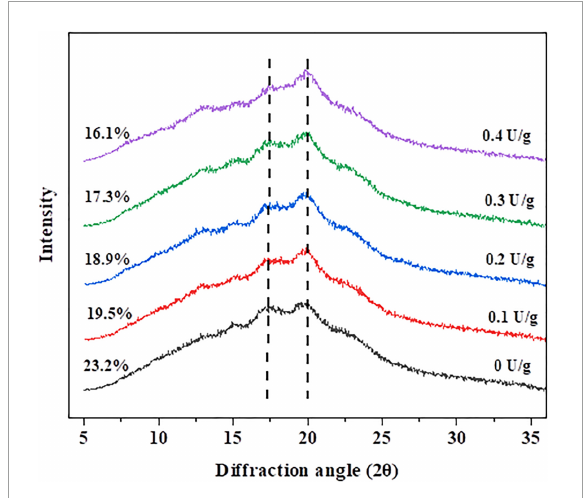
FIGURE3 The X-ray diffraction patterns of wheat bread with different levels of CGTase after storage at 20 ◦ C for 7